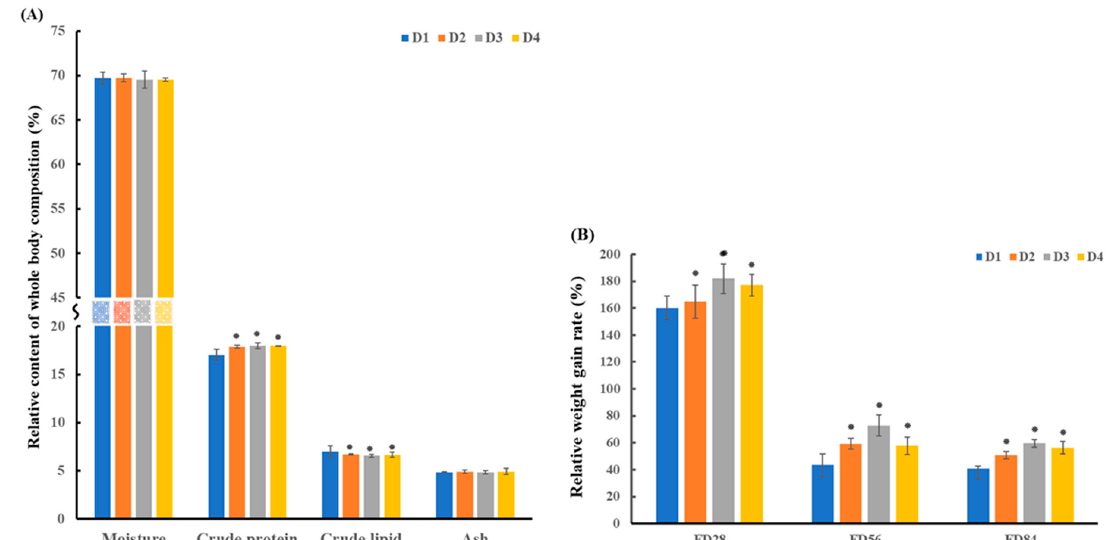
Figure 1. ( A ) The grouper whole-body composition at FD84 and ( B ) the weight gain rate (WGR) at FD28, FD56 and FD84 ( B ) with diets containing di ff erent taurine contents (D1: 0.0%, D1: 0.5%, D2: 1.0%, D3: 1.5%). Asterisk (*) indicates significant di ff erences between taurine-supplemented groups (D2, D3, and D4) and the control group (D1): p < 0.05.